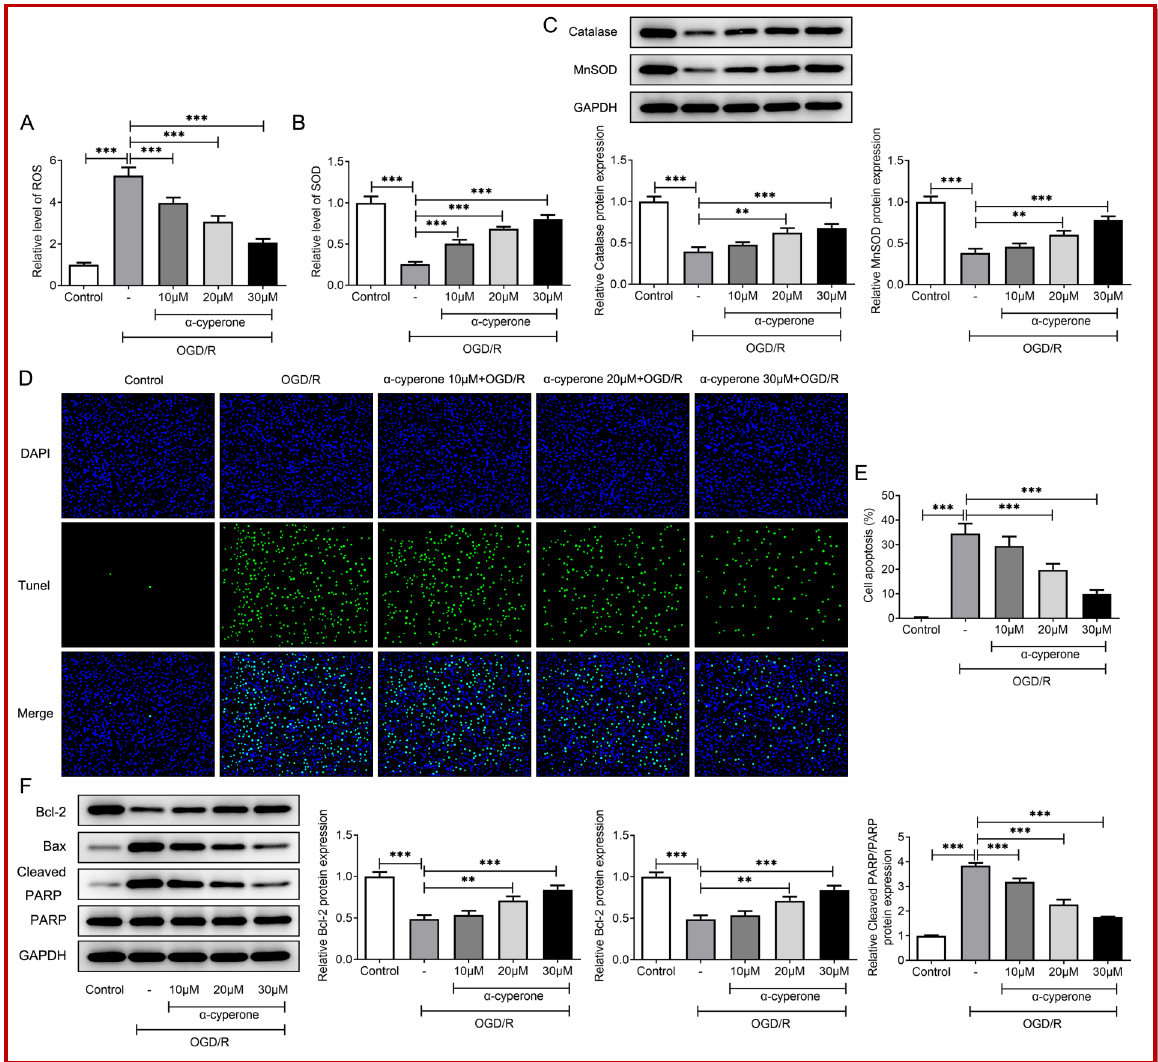
Figure 2: α -Cyperon reduces OGD/R-induced neuronal oxidative stress and apoptosis. The level of ROS (A) and SOD (B) in each group of cells was determined using assay kits. The levels of catalase and MnSOD were determined using Western blotting (C). The effect of α -cyperone on the level of cell apoptosis was evaluated using TUNEL assay (D-E) and Western blotting (F). Magnifi- cation, x200. a p<0.05, b p<0.01, c